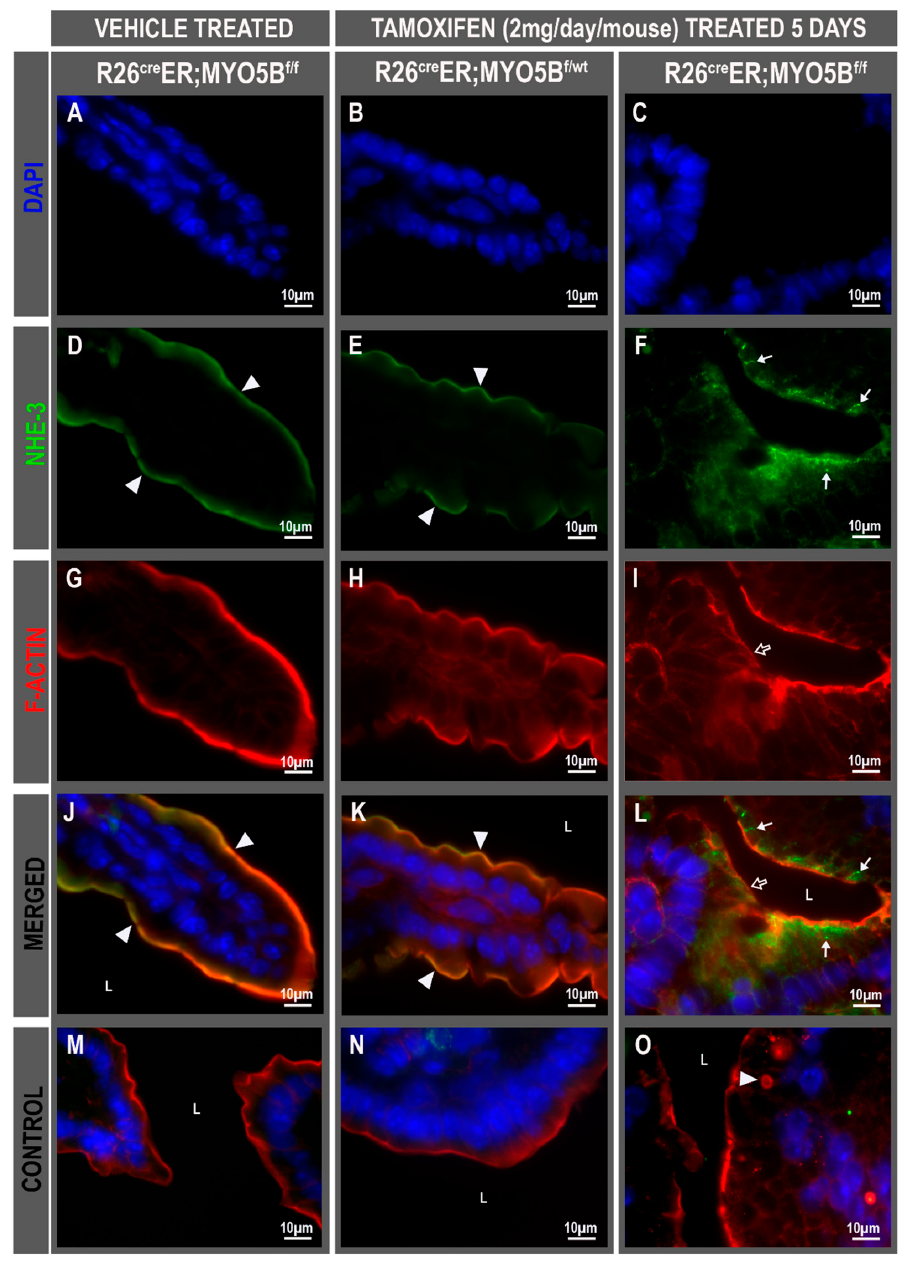
Figure 6. NHE3 is redistributed to subapical vesicular compartments in villus enterocytes of cMYO5bKO jejunum. Immunofluorescence localization of NHE3 in cryostat villus sections of jejunum from vehicle-treated R26 cre ER;MYO5B f/f or tamoxifen (2 mg/day/mouse)-treated R26 cre ER;MYO5B f/wt and R26 Cre ER;MYO5B f/f mice at day 5. Tissue sections were immunolabeled for NHE3 (green), F-actin (red), and DAPI (blue). Villus staining of DAPI ( A – C ) NHE3 ( D – F ) F-actin ( G – I ) merge ( J – L ) and control ( M – O ) from vehicle-treated R26 Cre ER;MYO5B f/f (Homozygous) ( A , D , G , J , M ) and tamoxifen-treated R26 Cre ER;MYO5B f/wt (Heterozygous) ( B , E , H , K , N ), or R26 Cre ER;MYO5B f/f (Homozygous) mouse jejunum ( C , F , I , L , O ). ( M – O ) Negative control staining with F-actin, Dapi, and secondary antibody only. The normal apical brush border localization of NHE3 (white arrowheads) observed in vehicle-treated homozygous ( D ), or tamoxifen-treated heterozygous mouse jejunum E, is redistributed to subapical vesicles (white arrows) in tamoxifen- treated homozygous mouse jejunum ( F , L ). ( O ) F-actin positive MI is detected (white arrowhead) in tamoxifen-treated homozygous mouse jejunum. Scale bars: 10 µ